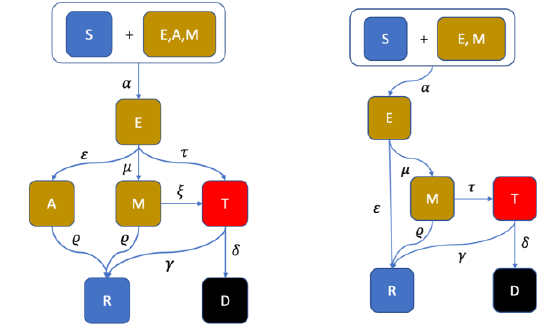
Figure 5. (left) Model-A, 7 states. (right) Model-B, 6